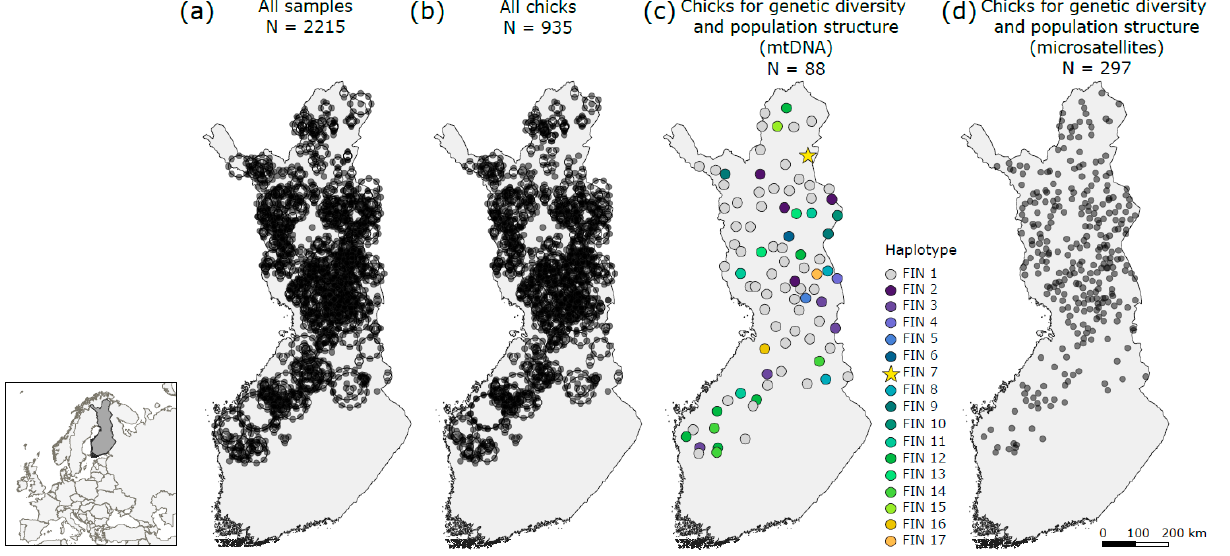
Figure 1. Sampling locations of individuals used in different analyses. ( a ) All samples. ( b ) All chick samples. ( c ) Chick samples used for genetic diversity and population structure analyses using mtDNA, with color codes for the detected haplotypes, indicating lack of population genetic structure. The Mediterranean haplotype (FIN7) is marked with the yellow star. ( d ) Chick samples used for genetic diversity and population structure analyses using microsatellites. Color intensity in pan- els ( a , b ) indicate sampling density, i.e., the darker the color, the more samples there are from the location, and multiple samples from a single location are arranged in rings.